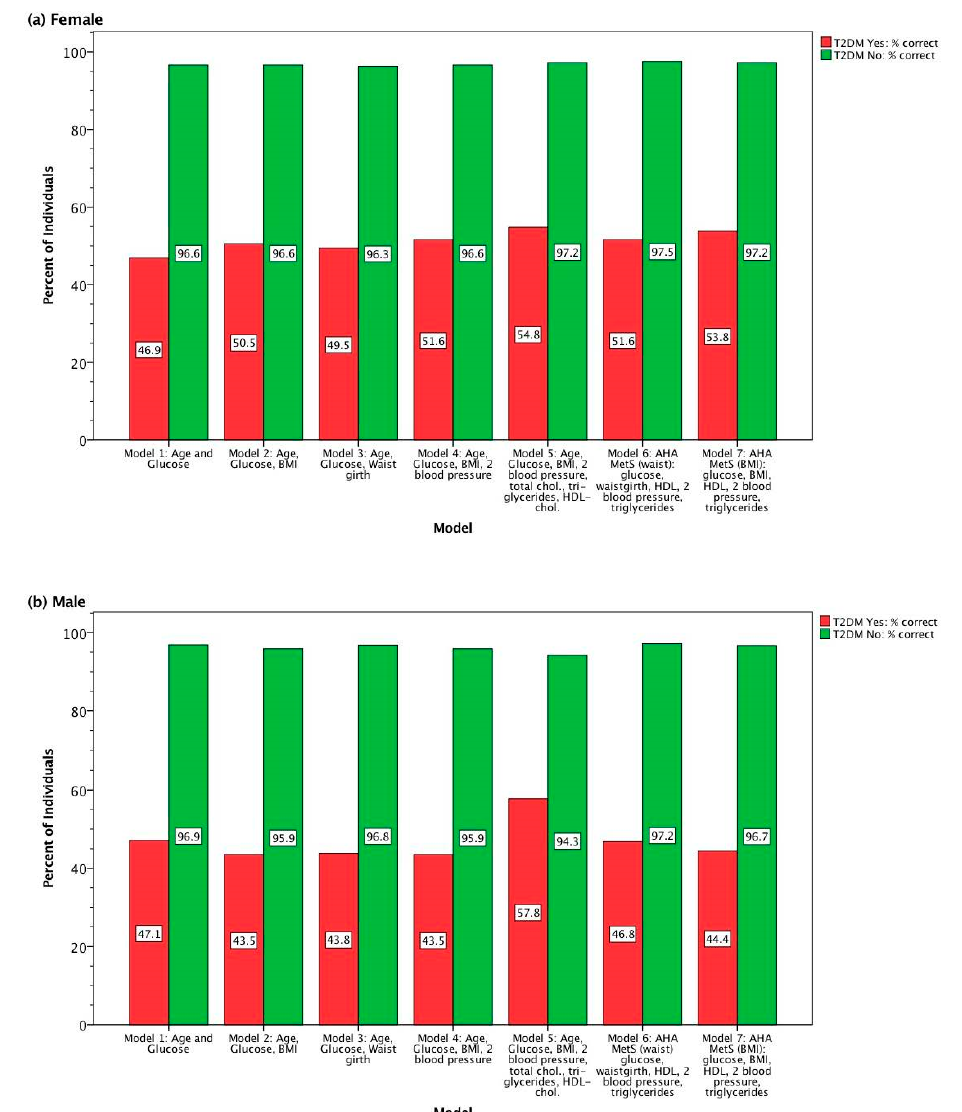
Figure 2. Percent correct classification of type 2 diabetes mellitus (T2DM) and non-T2DM individuals from discriminant functions analysis, for ( a ) females, and ( b ) males.